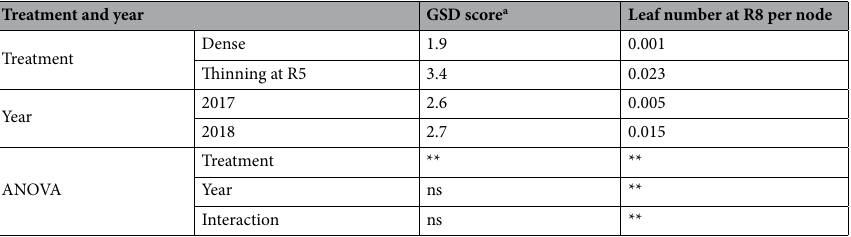
Table 4. Effects of thinning on GSD severity and plant growth parameters in experiment 3. Statistical analyses were performed using the statistical software BellCurve for Excel version 3.21. **Significantly different ( p < 0.01). *Significantly different ( p < 0.05). a ANOVA was conducted after Box-Cox transformation.